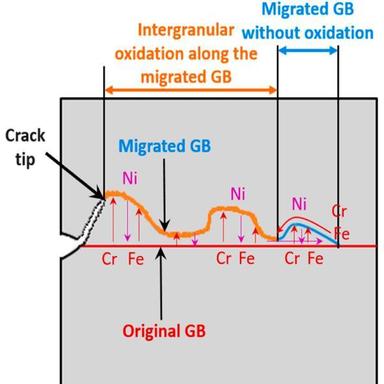
Schematic image showing the diffusion of Fe, Cr, and Ni ahead of SCC crack tip during the process of PIO and DIGM.